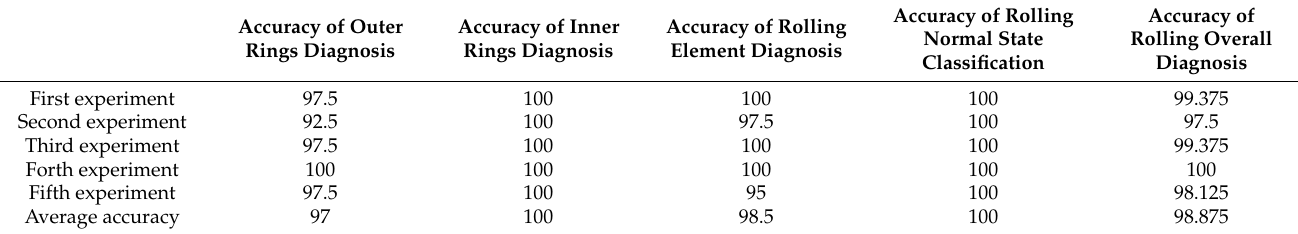
Table 6. Experiment results of multiple rolling bearing fault